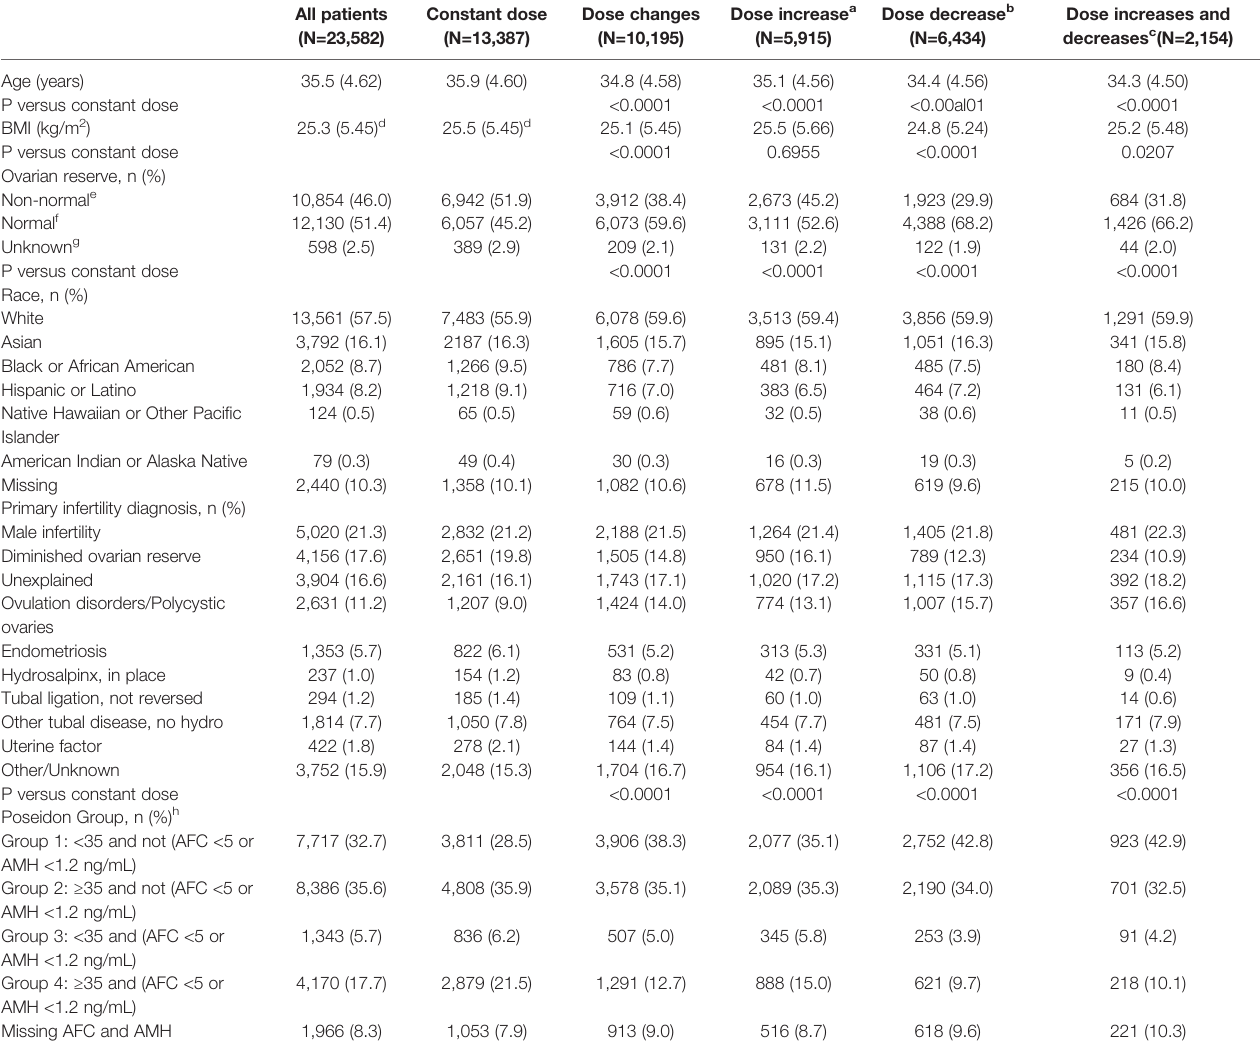
TABLE 1 | Patient baseline characteristics by dosing pattern.